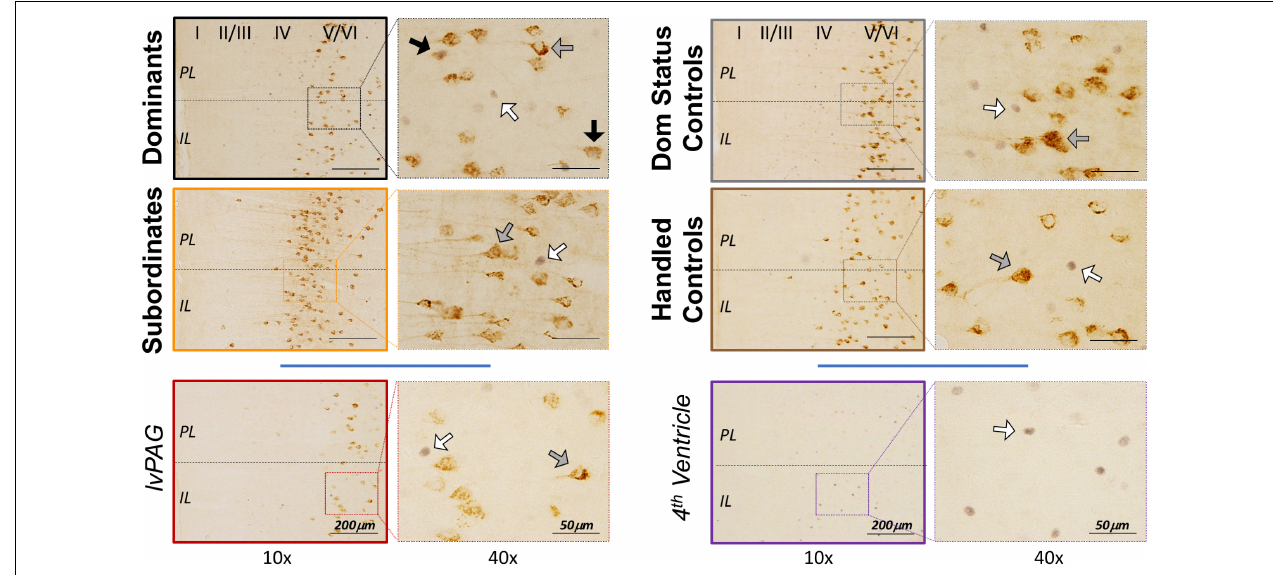
FIGURE 3 | Representative vmPFC histology by treatment group, including control injections in the left ventral periaqueductal gray (lvPAG) and 4th ventricle. CTB+ cells were localized primarily in deep cortical layers (V/VI) as depicted in left panels at 10 × magnification. Arrows highlight cFos-only (white), CTB-only (gray), and cFos+ CTB cells (black) and are presented at 40 × magnification for clarity. Importantly, images here do not depict quantification or selection methods (see Histology). Notably, the dominant and subordinate subjects shown here were also selected to represent CTB diffusion in Figure 2B .